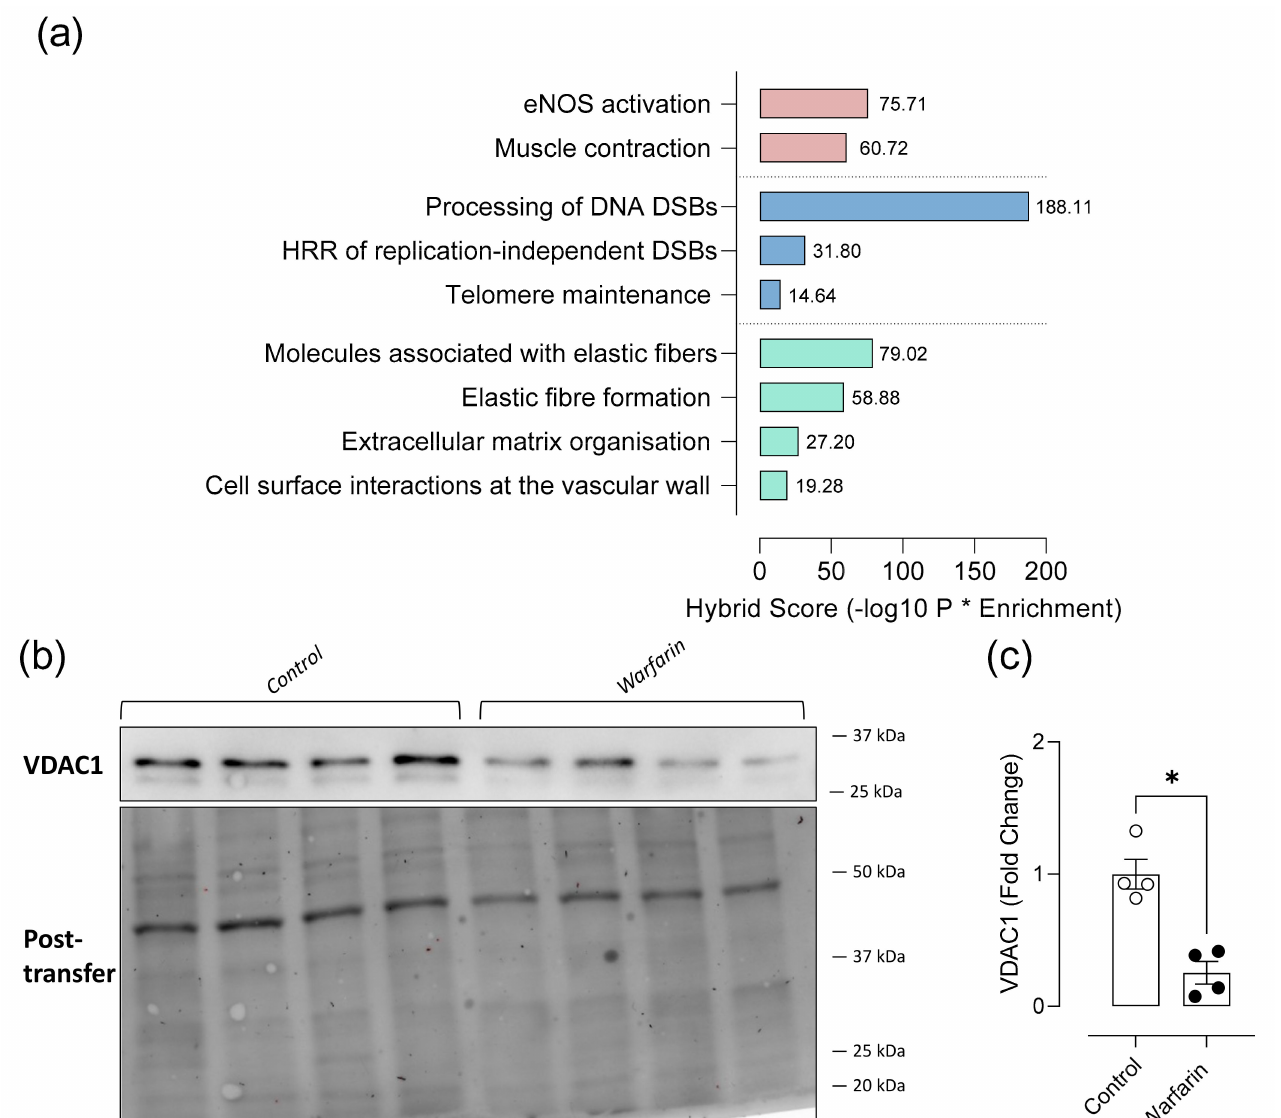
Figure 5. Protein identification and Reactome pathway analysis suggest a potential role for endothelial involvement in the aortic calcification process in mice. Reactome pathway analysis was performed from a Zero-order human PPI network using a specific aortic protein database. A hybrid score (negative log10 of enrichment probability multiplied by the enrichment ratio) was assigned for each specific pathway consisting of a subset of input proteins and bridging proteins. ( a ). Expression of aortic Vdac1 was visualized using Western blotting ( b ) and total lane protein normalization (Post-transfer) was done using ImageLab (Biorad) software ( c ) (Control: n = 4, Warfarin: n = 4). Two-tailed Mann Whitney U test was used to assess statistical significance between two groups ( c ). Significance vs control: p ≤ 0.05: *. Lines and error bars represent mean ±